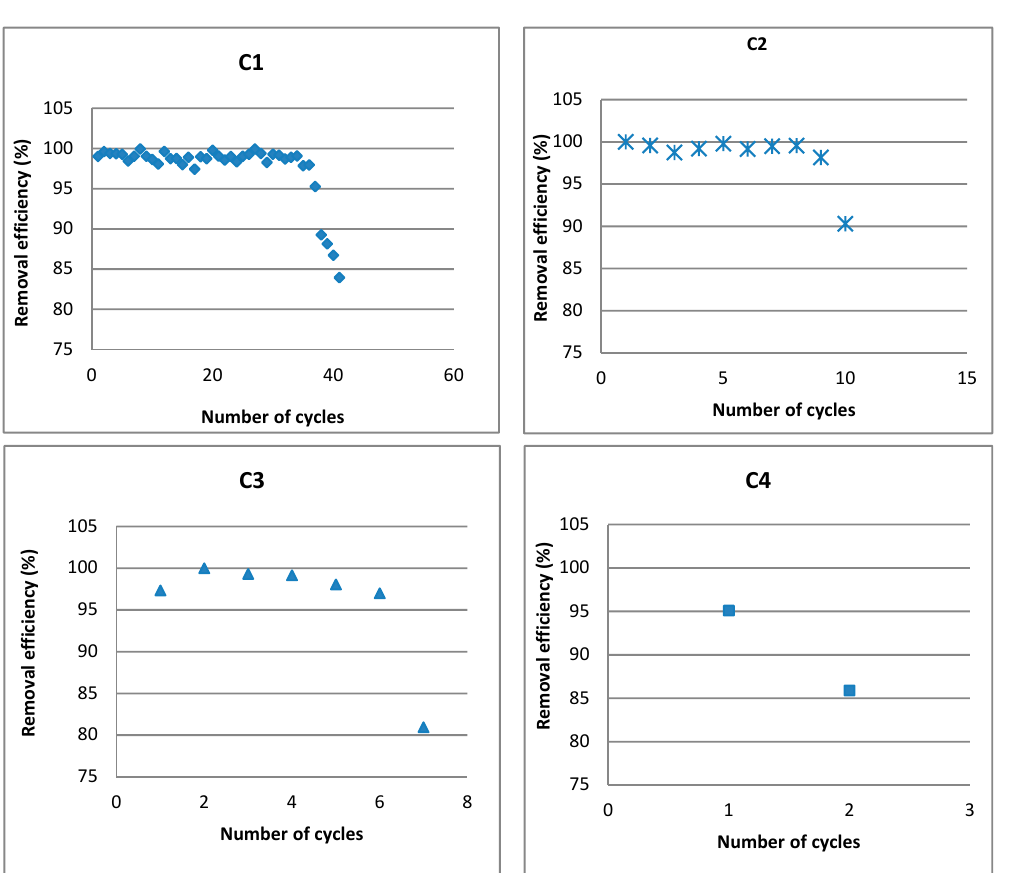
Table 5. TOC, IC, and TC of permeate in the adsorption columns after different cycles. Cx-yy: x is the name of the column, and yy is the number of cycles.